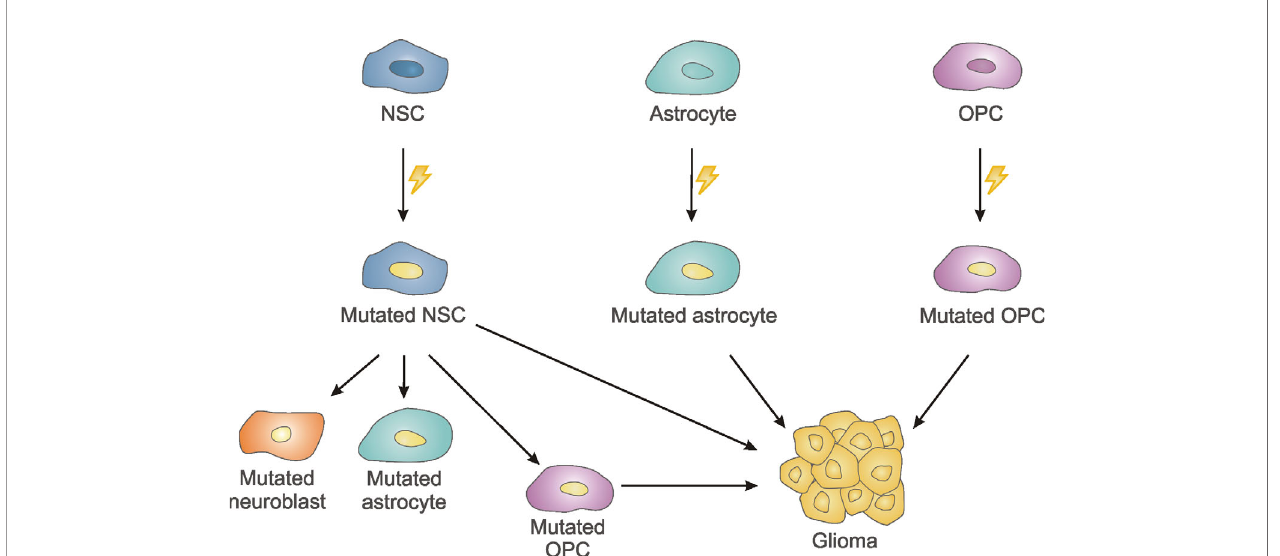
FIGURE 3 | Schematic drawing summarizing different theories on the cell of origin of glioblastomas. Neural stem cells (NSC) of the subventricular zone, astrocytes and oligodendrocyte precursor cells (OPCs) of the brain parenchyma might acquire cancer-driver mutations leading to gliomas. Additionally, NSC-derived mutations can be transmitted to their progeny generating mutated neuroblasts and mutated astrocytes, that do not likely give rise to tumor formation, or mutated OPCs with the ability to grow